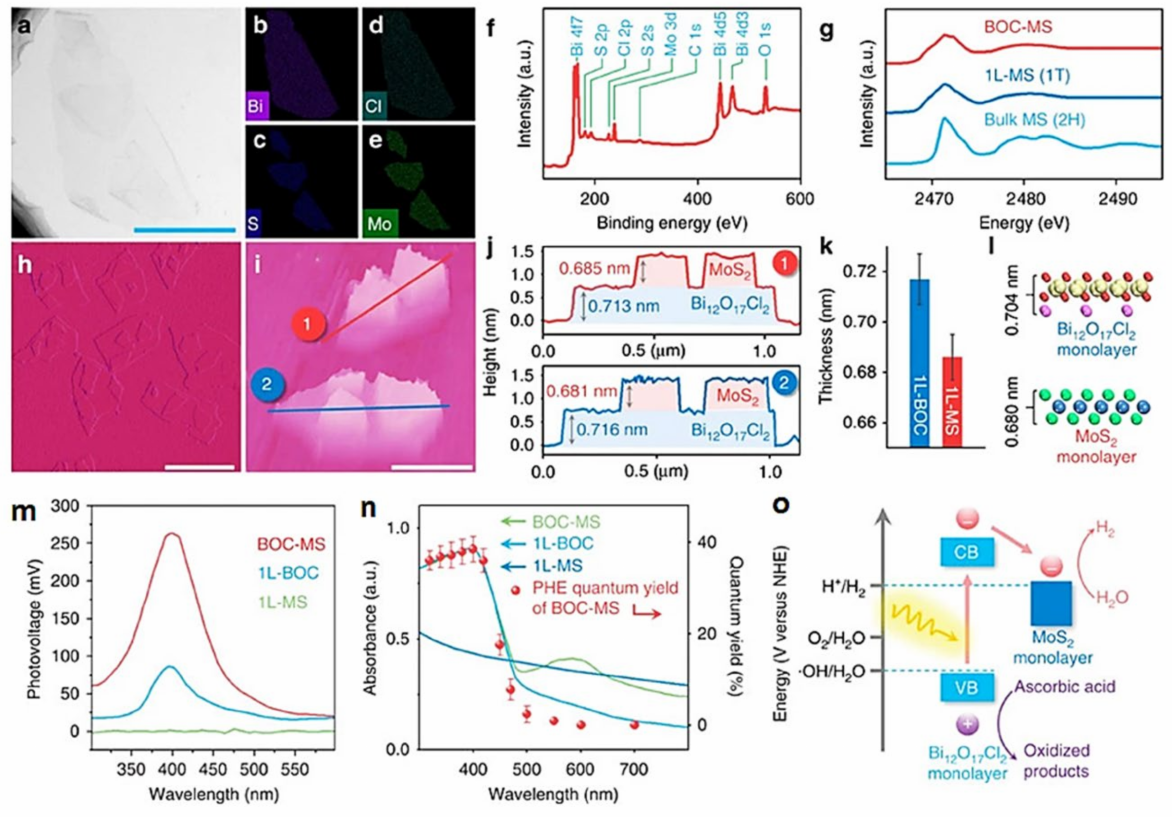
Figure 6. ( a ) Top-view TEM image; ( b – e ) elemental mapping images; ( f ) XPS spectra; ( g ) S K-edge X-ray absorption near edge structure spectra of Bi 12 O 17 C l2 -MoS 2 , 1L-MoS 2 and bulk MoS 2 ; ( h , i ) AFM images; ( j ) height profiles along the lines in I; ( k ) comparison of the average thicknesses of 1L- Bi 12 O 17 C l2 and 1L-MoS 2 in Bi 12 O 17 C l2 -MoS 2 monolayers; ( l ) the theoretical thicknesses of MoS 2 and Bi 12 O 17 C l2 monolayers; ( m ) surface photovoltage spectroscopy of 1L-Bi 12 O 17 C l2 , 1L-MoS 2 and Bi 12 O 17 C l2 -MoS 2 ; ( n ) UV-visible diffuse reflectance spectrum of Bi 12 O 17 C l2 -MoS 2 , 1L-Bi 12 O 17 C l2 and 1L-MoS 2 , and photocatalytic hydrogen evolution quantum yields of Bi 12 O 17 C l2 -MoS 2 monolayers plotted as a function of wavelength of the incident light; ( o ) band alignments in 1L- Bi 12 O 17 C l2